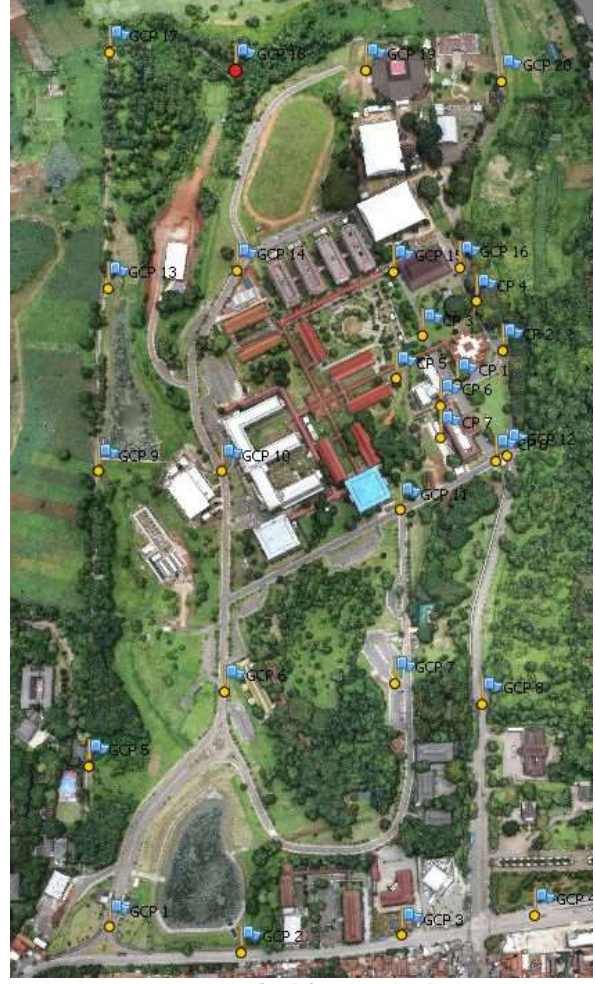
Figure 4. Dense Point Cloud from UAV-